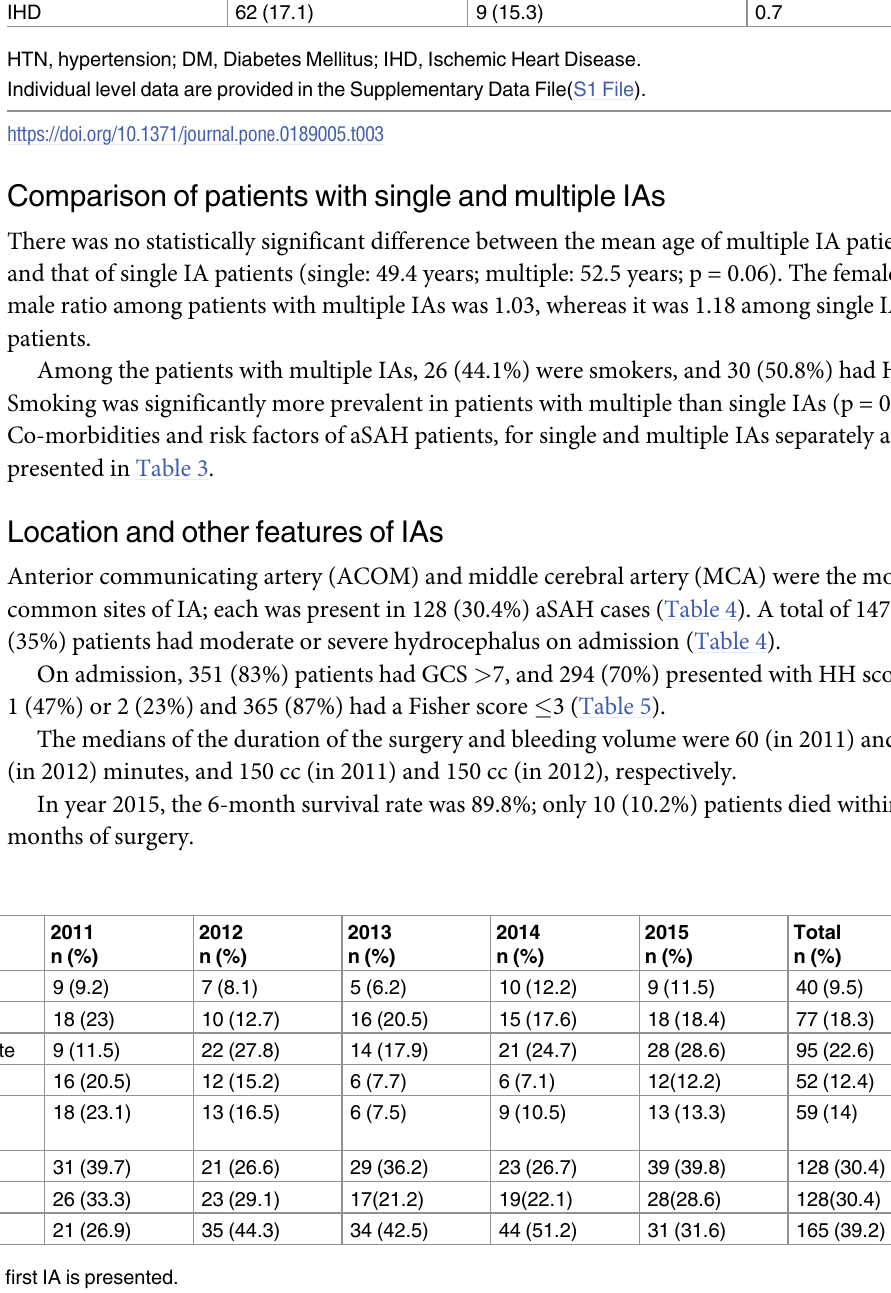
HTN, hypertension; DM, Diabetes Mellitus; IHD, Ischemic Heart Disease. Individual level data are provided in the Supplementary Data File(S1 File).